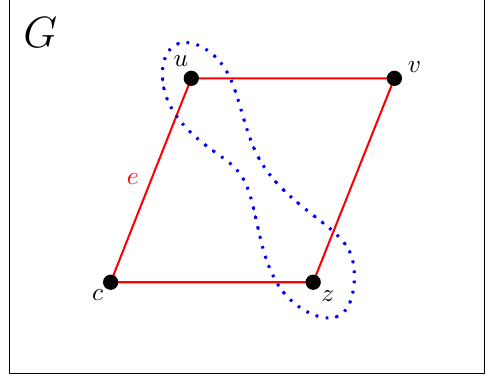
(c) Blue arcs represent a maximum flow with corresponding weights from ˜ c 1 ( (cid:4) ) to ˜ v 0 ( (cid:3) ); since m is a sufficiently large constant, the max- imum flow is w ( u ) + w ( z ) , limited by arcs in- duced by V (here: the dotted arcs ˜ a u , ˜ a z with weights w ( u ) , w ( z ) respectively). Figure 12: Computing a minimum-weight vertex